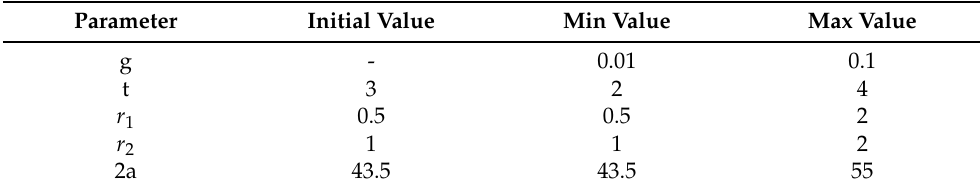
Table 1. Investigated ranges of geometrical parameters (dimensions in